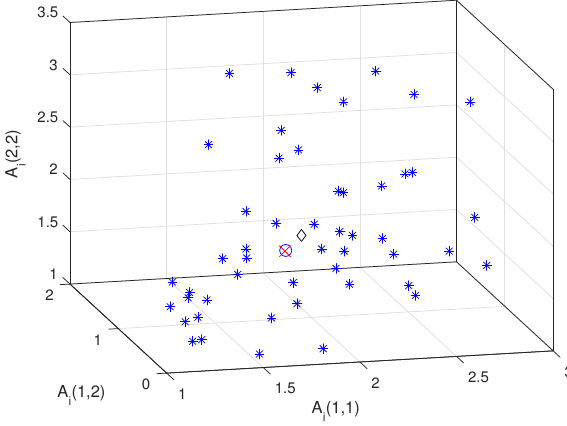
Figure 2. Mean of 50 samples.